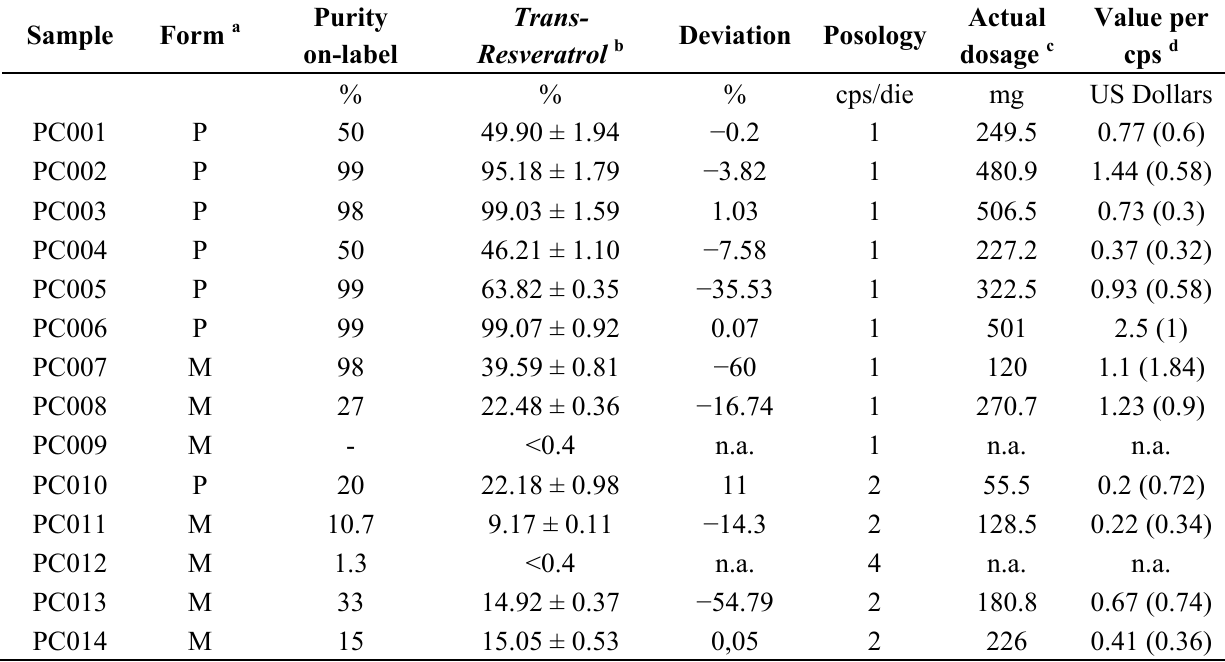
Table 2. T rans -Resveratrol abundance in 14 food supplements purchased online and actual amounts delivered to the